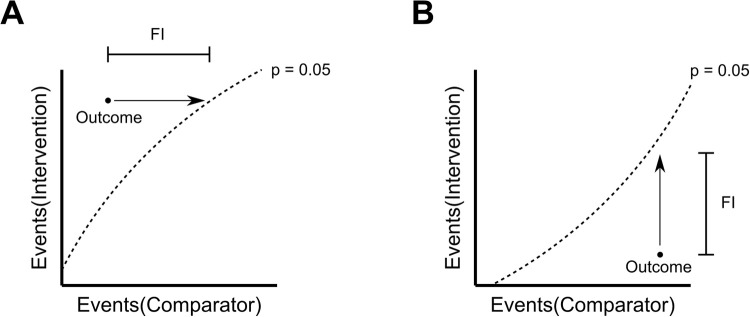
Schematic description of FI.(A) In the scenario where Events(Intervention) > Events(Comparator), FI is the horizontal distance to the boundary curve corresponding to P = 0.05 (dashed line). (B) In the scenario where Events(Comparator) > Events(Intervention), FI is the vertical distance to the boundary curve corresponding to P = 0.05 (dashed line).